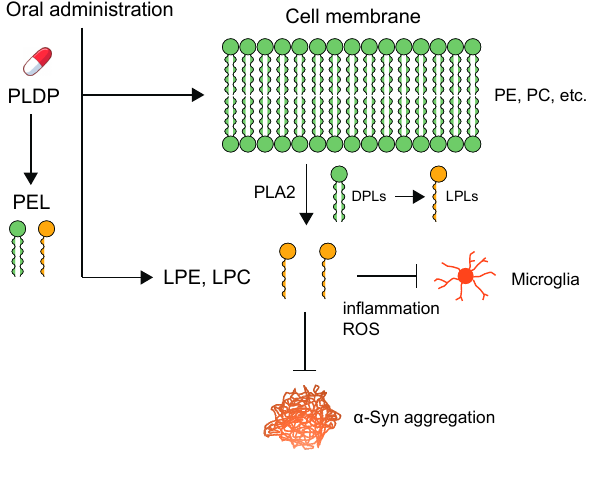
Figure 1. PLDP is a rich source of phospholipids. PLDP extracted lipids (PEL) was extracted from PLDP using the Bligh and Dyer method. This PEL is a rich source of LPLs, including LPC and LPE. LPC and LPE exerted significant protective effects against LPS-induced inflammation and oxidative stress in microglial cells. Various isoforms of PLA2 enzyme hydrolyze PC and PE at the sn-2 position to form LPLs, including LPC and LPE, respectively. α -Syn is bound to LPLs, which are known to be contained in PEL, strongly inhibit α -Syn aggregation.